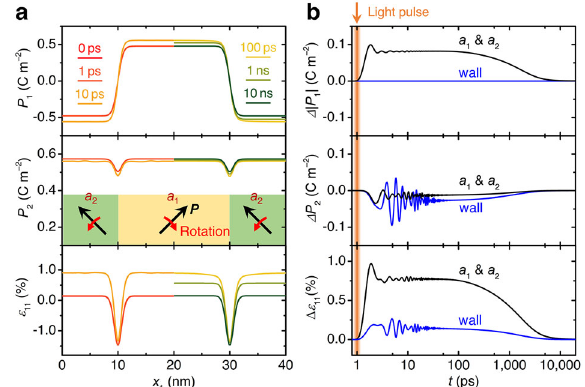
tail-to-tail domain walls. a Spatial distribution of initial and excited- state polarization P 1 , P 2 , and strain ε 11 at selected times. All 3 fi elds are symmetric about x 1 = 20 nm. For clarity, we only show the x 1 < 20 nm half of the data at t (cid:6) 10 ps and x 1 > 20 nm half of the data at t > 10 ps . The middle panel contains a schematic showing polariza- tion rotation of each domain. The average lattice parameter within the whole sample before the light excitation is used as a reference for calculating ε 11 , i.e., the average original ε 11 is set as zero. b Temporal evolution of the changes Δ P 1 j j , Δ P 2 , and Δ ε 11 inside a 1 and a 2 domains and at the center of domain walls, with respect to the initial